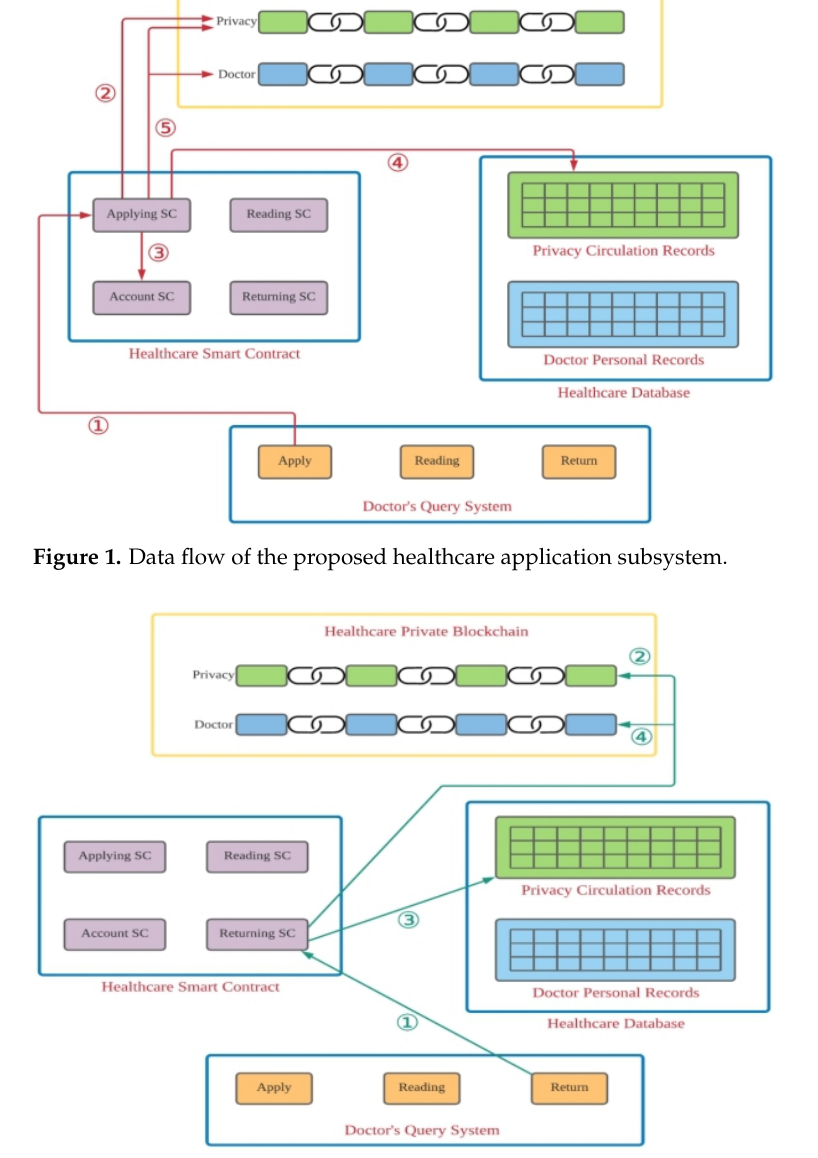
Figure 2. Proposed privacy check using the cross-domain